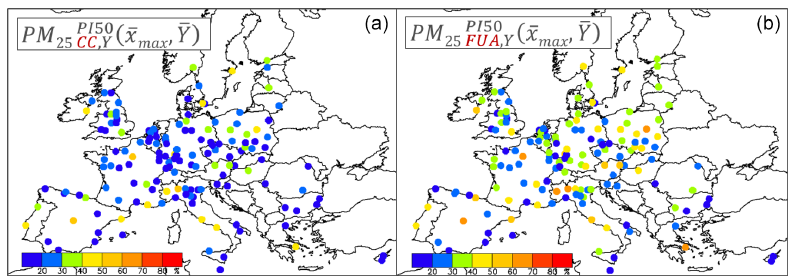
Figure 4. Maps of city contributions obtained for spatial sources defined in two ways: core city (CC; a ) and FUA (b) . Results are shown for 150 cities in Europe based on the SHERPA-CHIMERE model using a potential impact SA method for a reduction strength of 50% (PI50). The indicator is the total PM 2 . 5 concentration. The receptor is selected as the location where the maximum yearly average concentration occurs ( x max ) and applies a yearly time average ( Y ). The source emissions are reduced over a full year ( Y ).